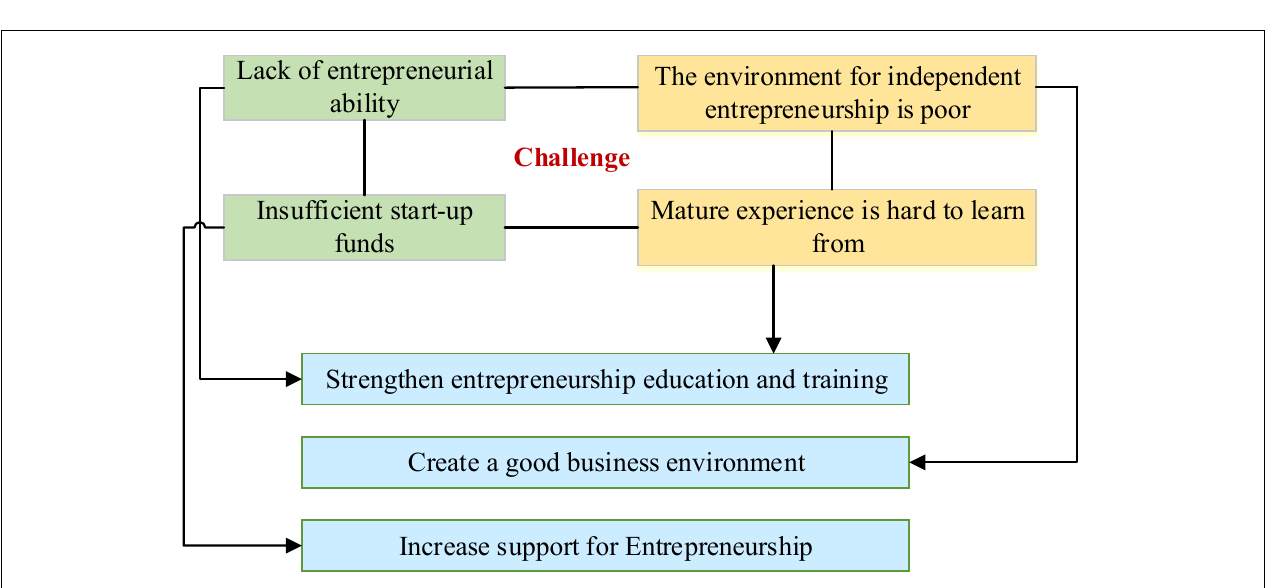
FIGURE 3 | The challenges faced by college students during entrepreneurship and the corresponding solutions under “Internet+” context.